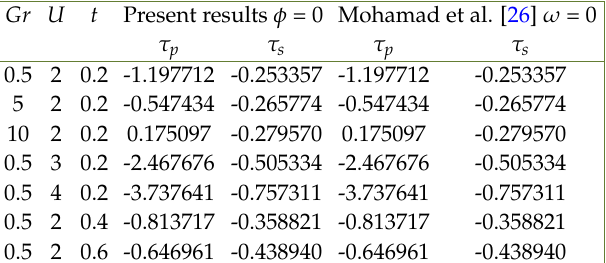
Fig. 8. Verification of present results with published results from Mohamad et al. [26]. Table 4. Comparison of skin friction values at Pr =6.2.